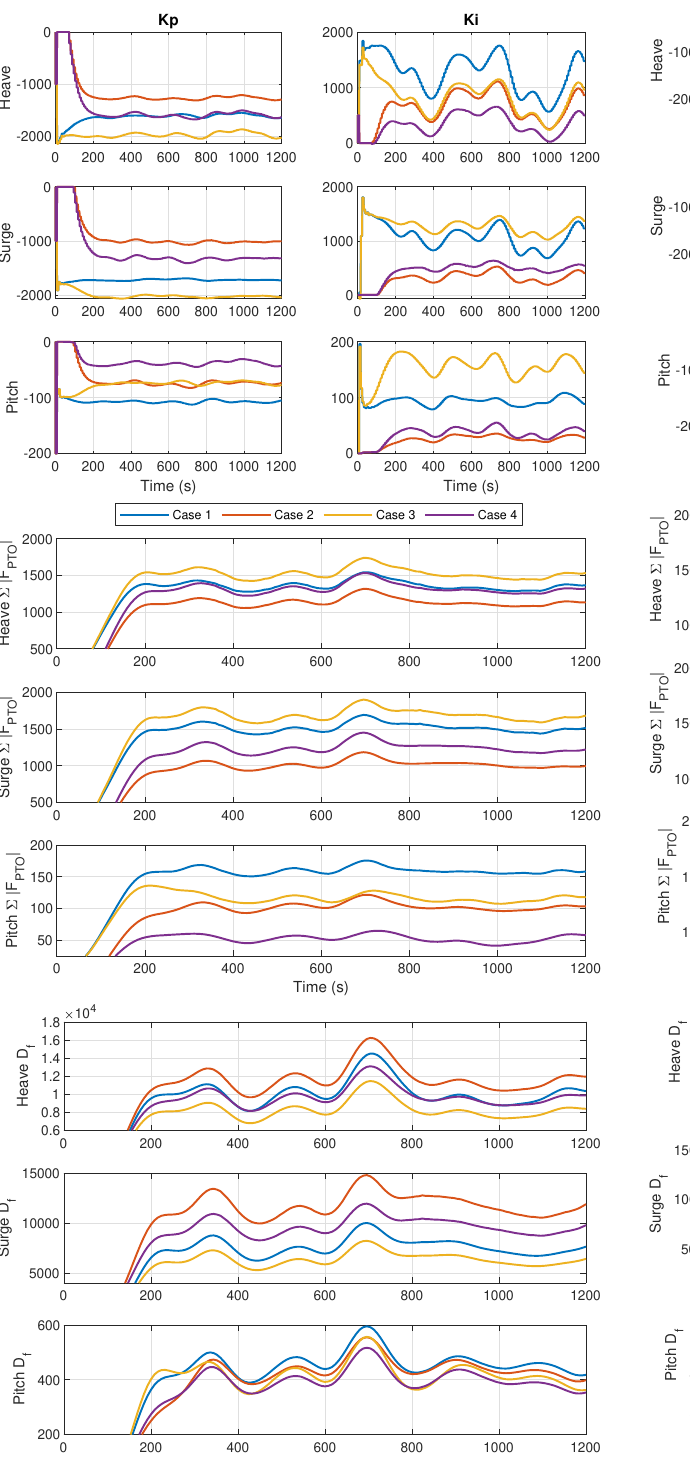
(cid:80) | F Fig. 12: Controller gains (top), PTO | (middle), (cid:80) | F Fig. 11: Controller gains (top), F TOT (bottom) over time (s) for heave, surge, and pitch. PTO | (middle), F TOT (bottom) over time (s) for heave, surge, and The legend given on the middle figure is used through- pitch for the static weight case. The legend given out, with the color denoting controls objectives, and the on the middle figure is used throughout, with the line style indicating weight adaptation approaches. The color denoting controls objectives, and the line style horizontal black dashed line indicates the threshold indicating weight adaptation approaches. (Eq. 23) for each objective and degree of freedom.